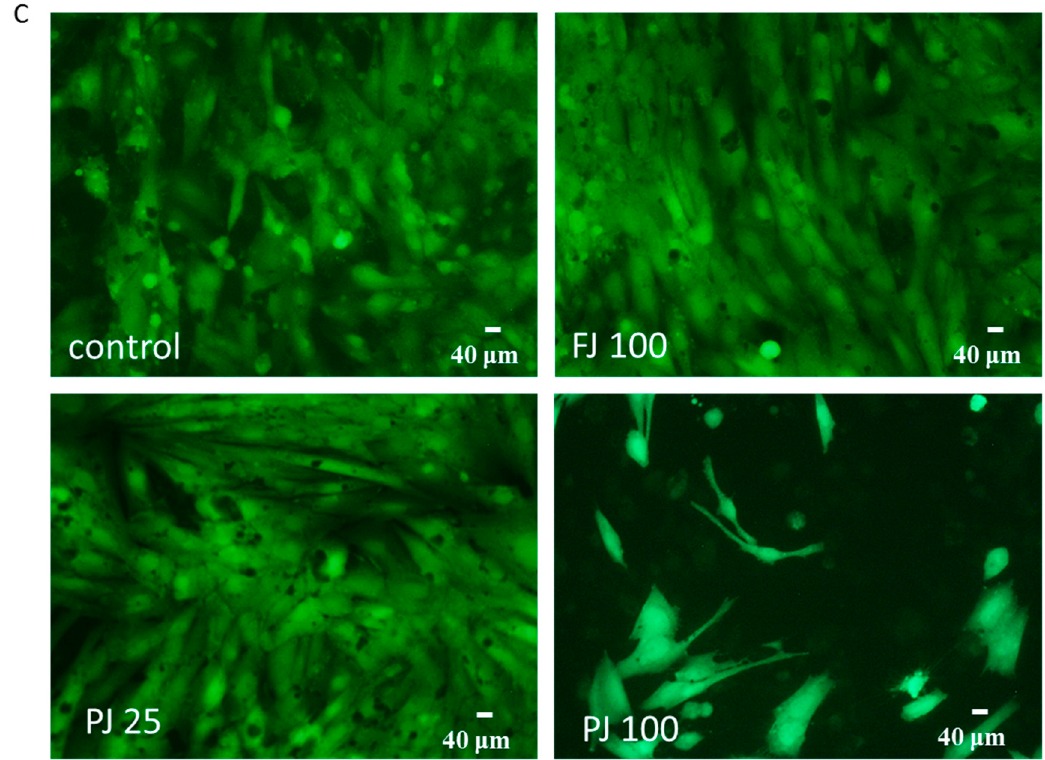
Figure 3. The influence of V. opulus on Saos-2 cell proliferation, determined by CyQuant reagent after 48 h exposure with FJ ( A ) and PJ ( B ); control cells were not exposed to any compound; values are means ± SEM, n ≥ 12; statistical significance was calculated versus control cells (untreated), ** p ≤ 0.01, *** p ≤ 0.001. Morphology of Saos-2 cells stained with 2 µ M calcein AM observed after incubation with 25 and 100 µ g / mL of PJ, and 100 µ g / mL of FJ ( C ); randomly chosen fields were photographed at × 400 with fluorescent microscope.